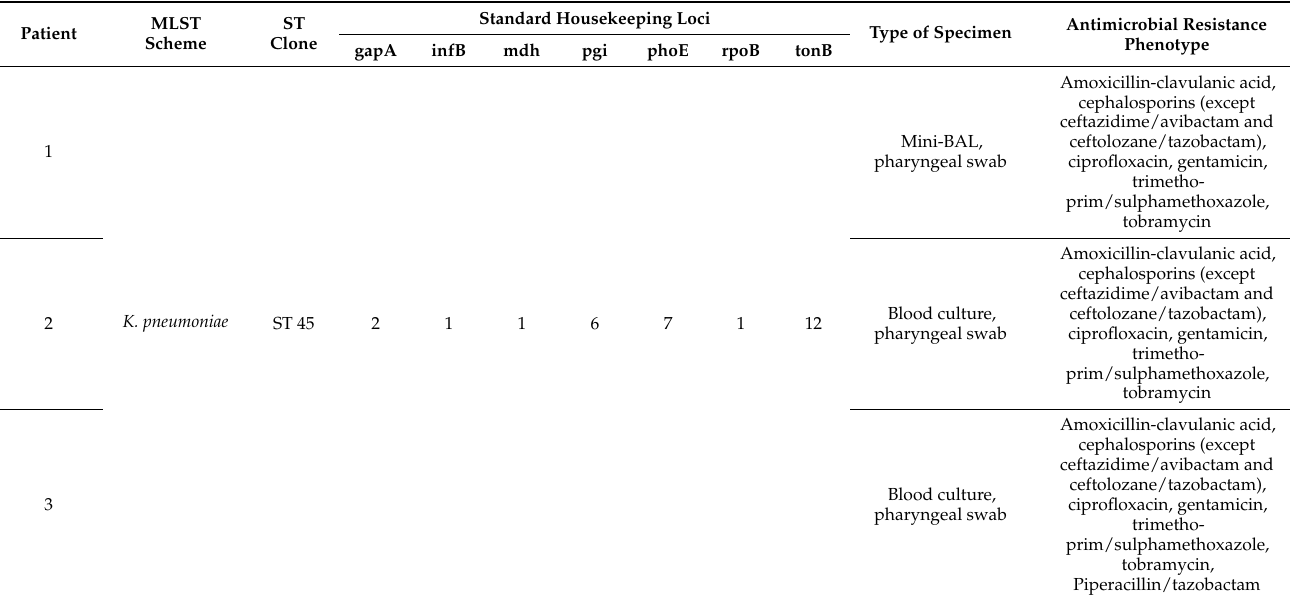
Table 1. Results of multilocus sequence typing (MLST) using seven genes (gapA, infB, mdh, pgi, phoE, rpoB, and